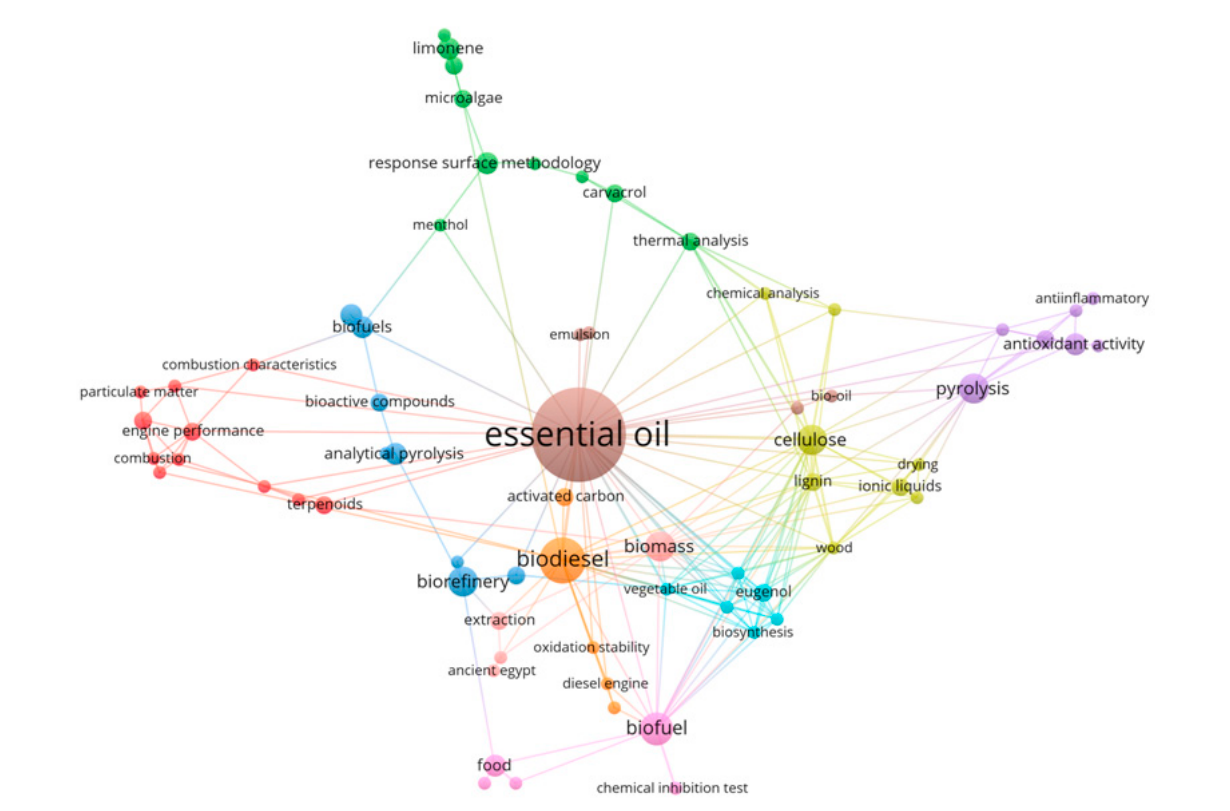
Figure 5. VOSviewer co-occurrence network visualization mapping the most frequent keywords (minimum of two occurrences) in Web of Science research on biodiesel production from essential oil.